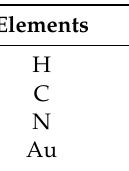
Table 1. The atomic orbitals involved in the calculation.